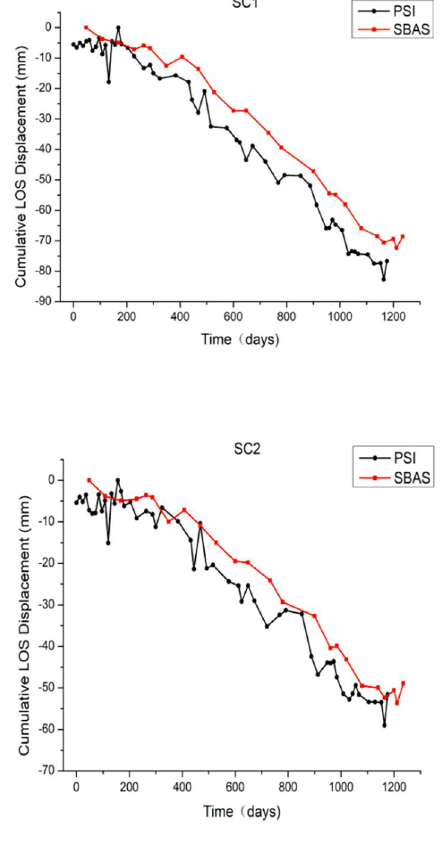
Figure 14. The representative sites in the area behind the school.